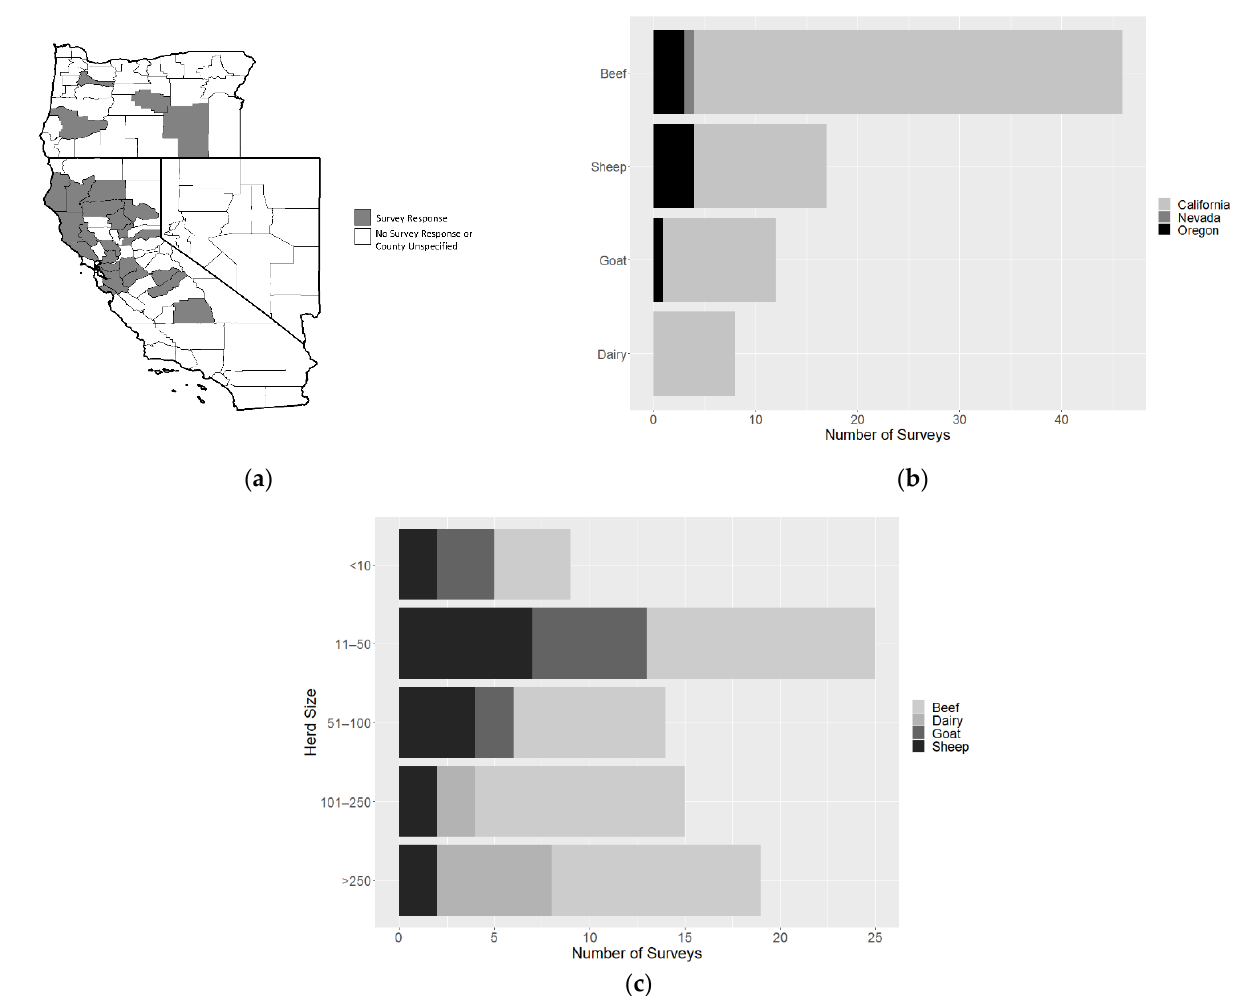
Figure 1. Livestock producers responding to a survey on 2020 wildfire impacts on livestock production and health, ( a ) mapped by county of origin (note: 25/70 respondents did not identify their county), ( b ) by livestock type and state, ( c ) by livestock type and herd size.